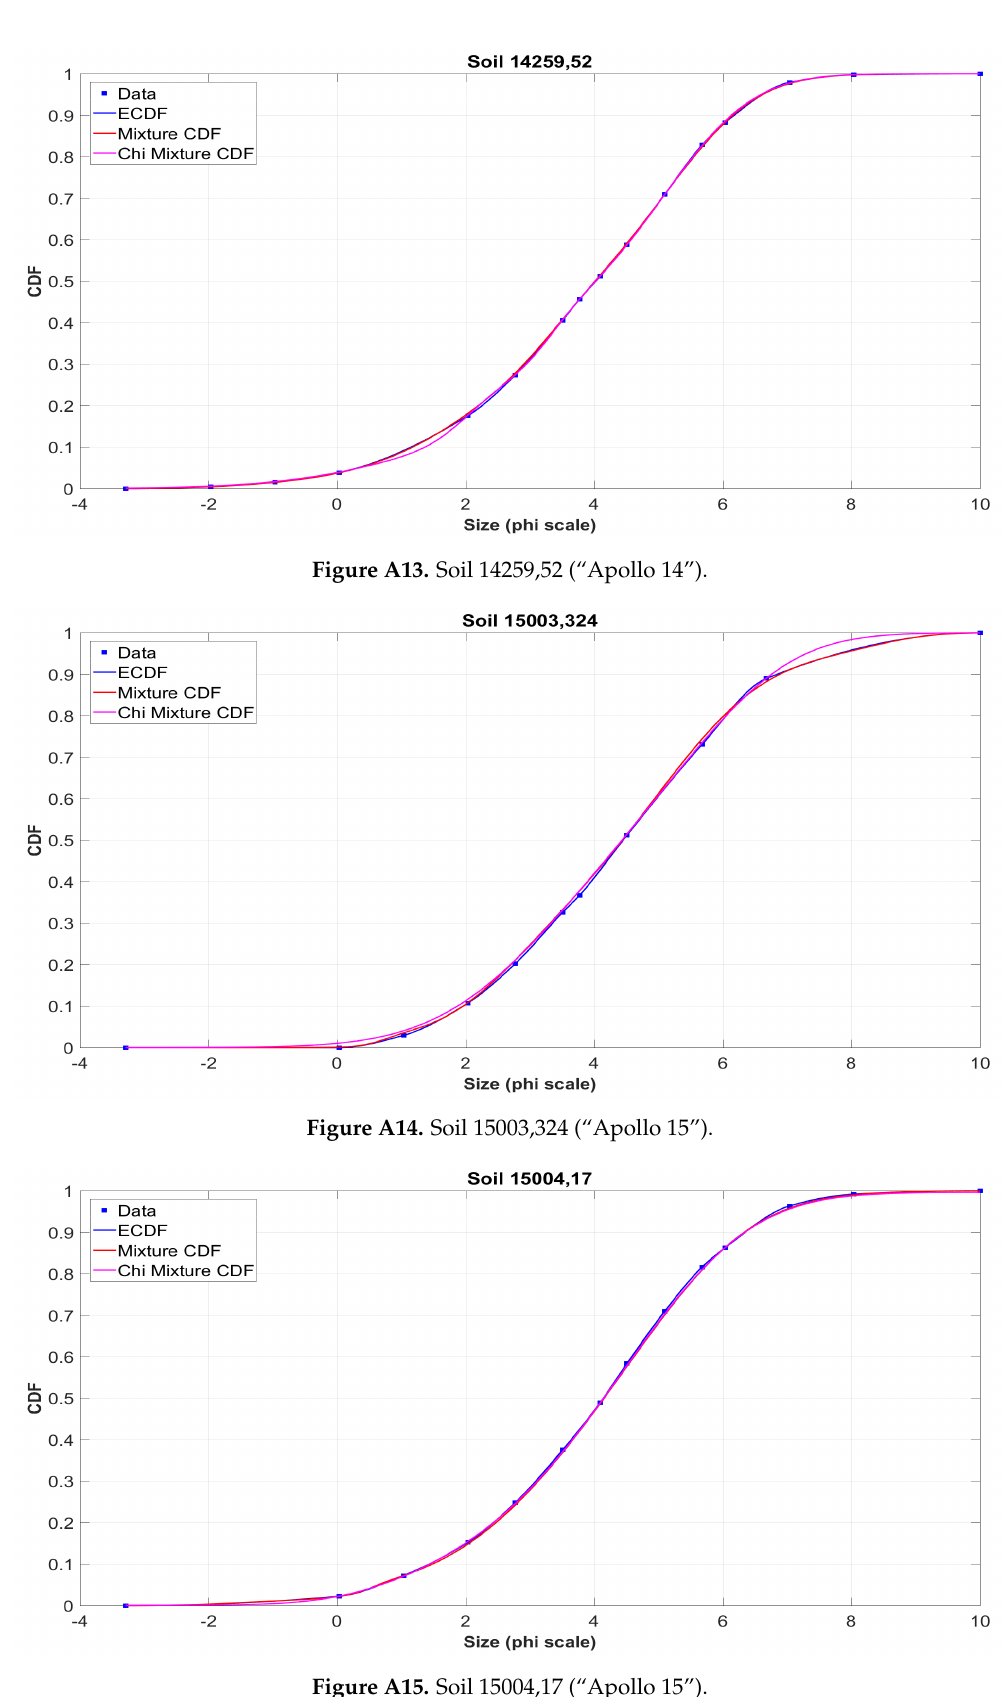
Figure A15. Soil 15004,17 (“Apollo